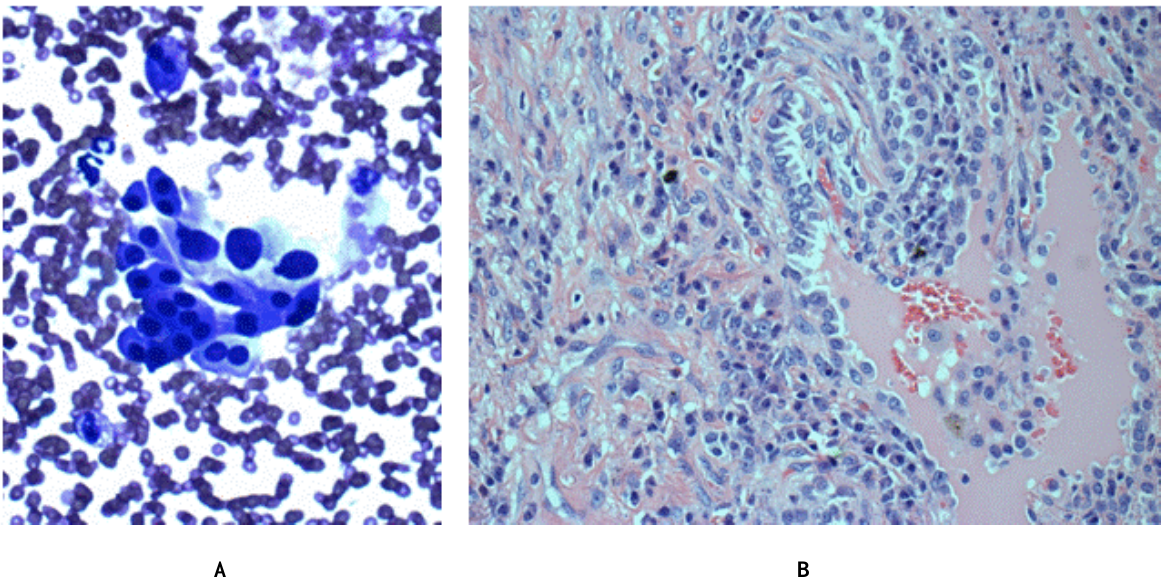
FIGURE 2. FNA biopsy (A) and VTLB (B) of the lung lesions in a 62-year-old lady who presented with multiple pulmonary nodules. (A) Atypical cells on cytology suspicious of large cell carcinoma; (B) equivalent cells (pneumocytes) in tissue section.